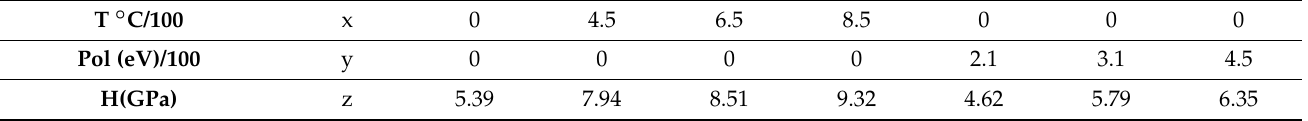
Table 6. Multiple linear regression of two independent